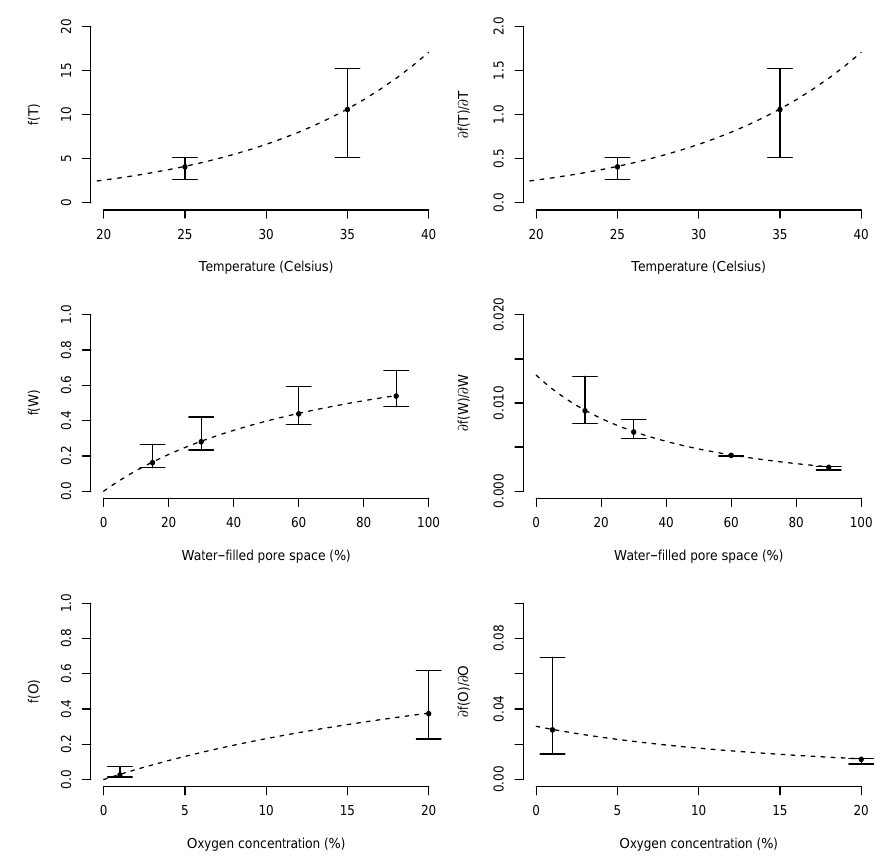
Figure 4. The shape of the response functions f (T ) , f (M) , and f (O) (dashed lines) calculated with the mean values of the posterior parameters and their respective sensitivities ∂f (T )/∂T , ∂f (M)/∂M , and ∂f (O)/∂O . The predictions for the treatment levels used in the experiment are presented as points with their respective 5–95%